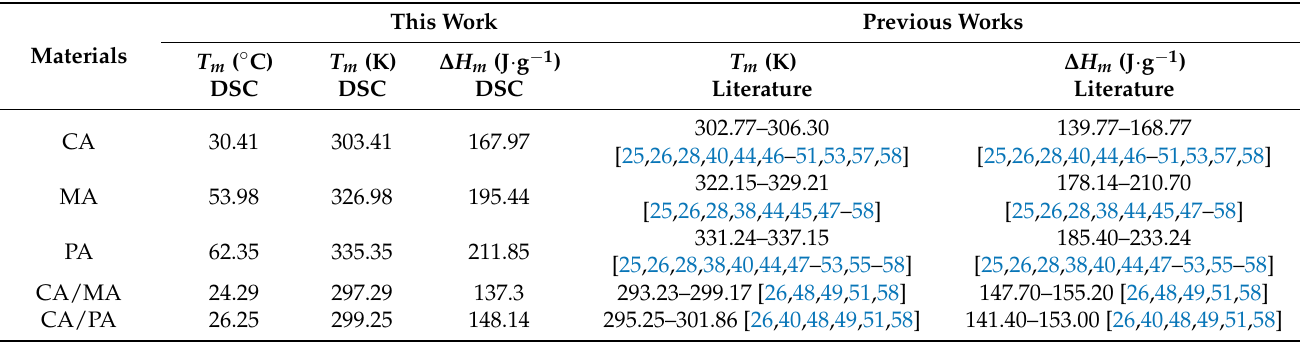
Table 4. Melting temperatures and enthalpies obtained using the DSC (this work) compared to those from the literature [25,26,28,38,40,44–58] at pressure p = 0.1 MPa *. This Work Previous Materials